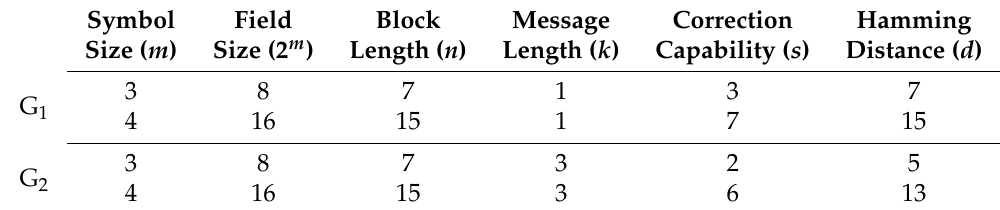
Figure 1. Conceptual overview of the experimental setup. Table 2. Reed–Solomon Codes setup